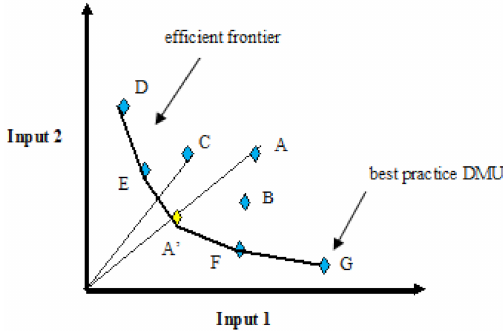
Figure 3. E ffi ciency frontier in the DEA model with two-input and single-output